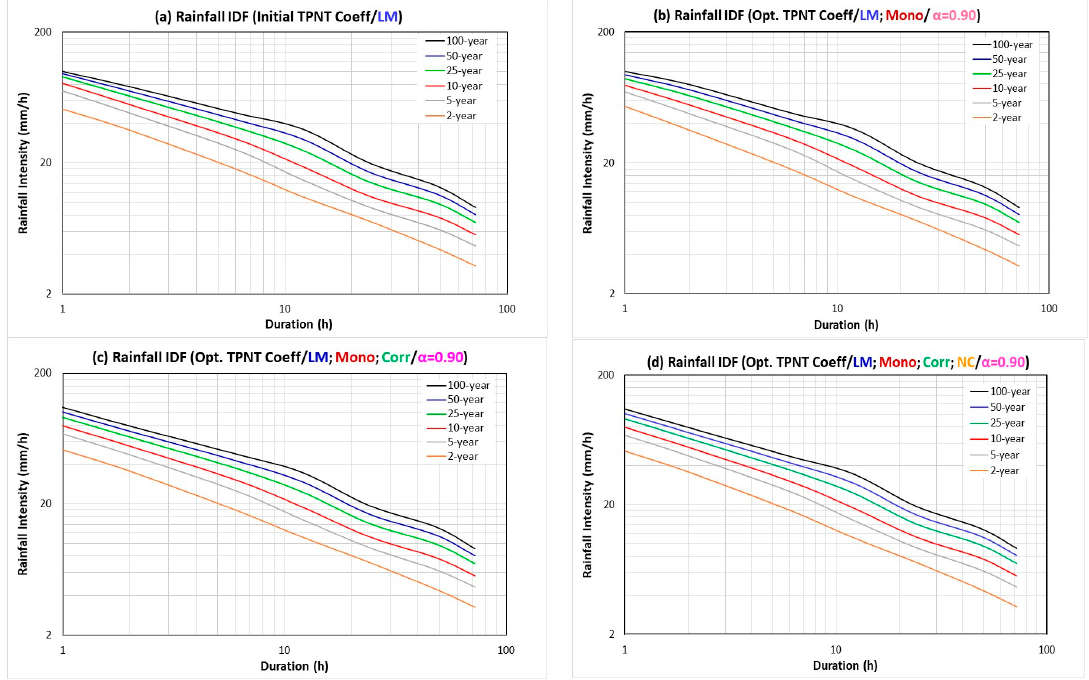
Figure 2. Multivariate TPNT modeling of rainfall intensity–duration relationships of varying return periods under different constraints which consider: ( a ) L-moments only; ( b ) L-moments and monotonicity; ( c ) L-moments, monotonicity and correlation; ( d ) L-moments, monotonicity, correlation and no crossover.